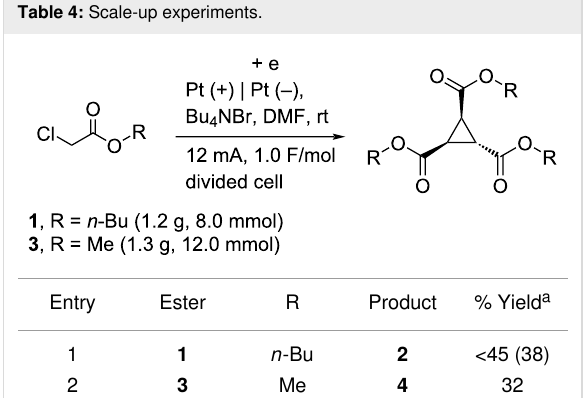
Table 4: Scale-up